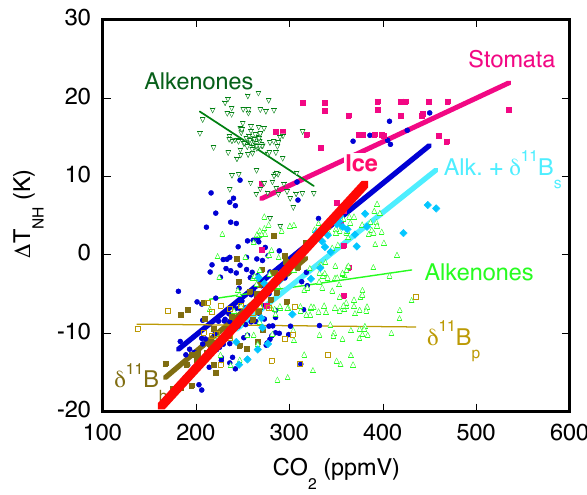
Fig. 4. Scatter plot of the different CO 2 proxies as a function of the reconstructed temperature, which is derived from the benthic δ 18 O record as shown in Fig. 1. Only records with filled symbols δ 11 B h (H¨onisch et al., 2009), B/Ca (Tripati et al., 2009), alkenones+ δ 11 B s (Seki et al., 2010), stomata data (K¨urschner et al., 1996, 2008; Re- tallack 2009), and the ice-core record (Petit et al., 1999; Siegen- thaler et al., 2005; L¨uthi et al., 2008) are used for further analysis. For reasons of transparency CO 2 is plotted inppmv. If CO 2 would be plotted as ln(CO 2 /CO 2 , ref ) a similar picture emerges. The latter is physically more consistent as it takes the saturation of the absorp- tion bands into